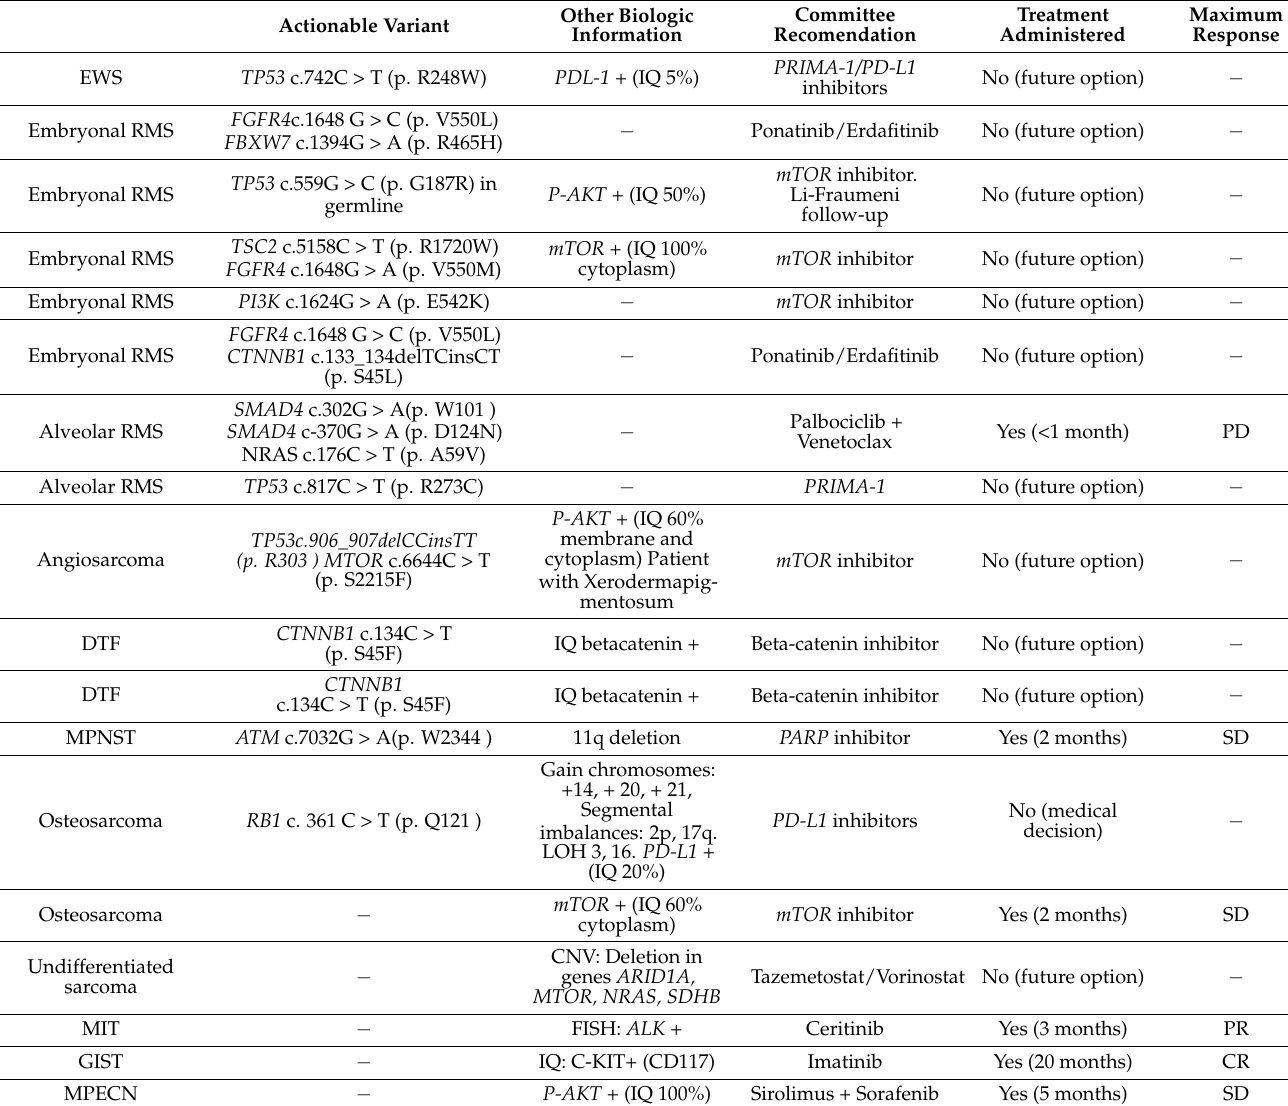
Table 3. Clinical translation: Actionable variants detected, molecular tumour board recommendations, targeted treat- ments administered and results observed. EWS: Ewing sarcoma; IQ: immunochemistry; RMS: rhabdomyosarcoma; DTF: desmoid-type fibromatosis; MPNST: malignant peripheral nerve sheath tumour; LOH: loss of heterozygosity; CNV: copy number variation; MIT: myo-fibroblastic inflammatory tumour; GIST: gastrointestinal stromal tumour; MPECN: malignant perivascular epithelioid cell neoplasm; PARP: poly ADP-ribose